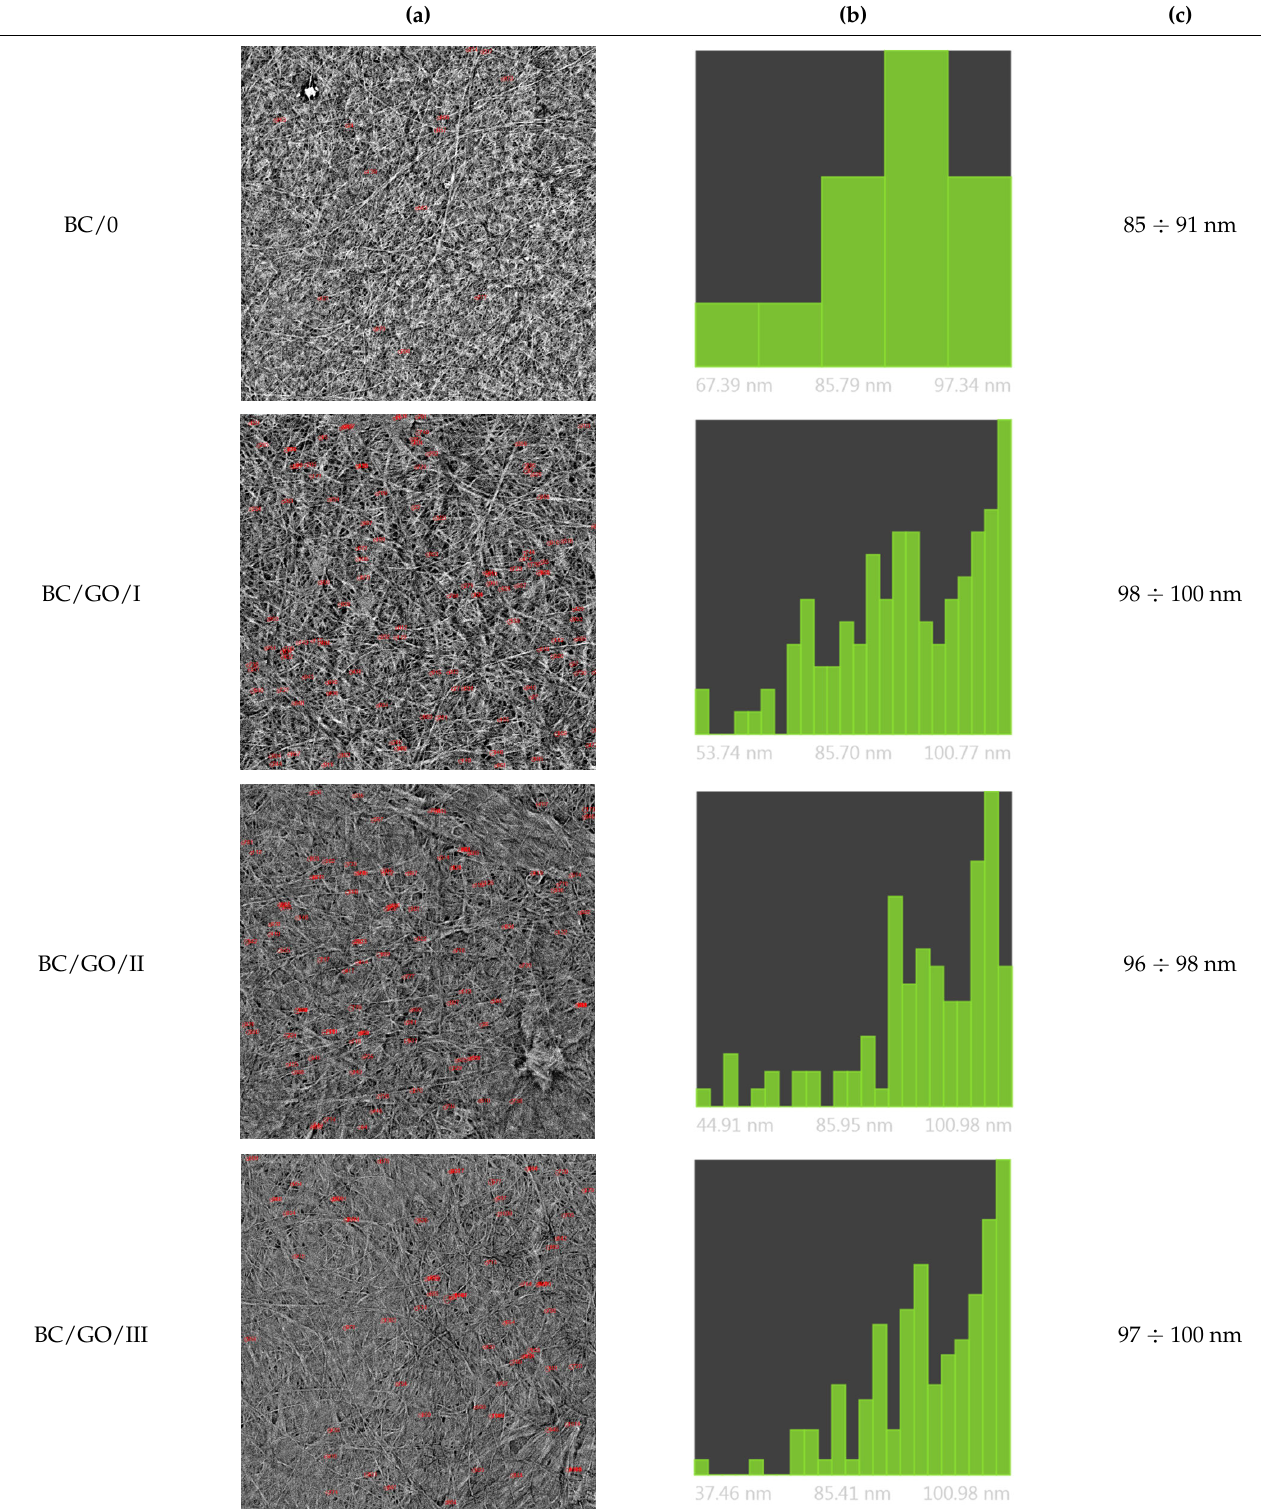
Table 3. Thickness dispersion of BC fibers in the following membranes: BC/0, BC/GO/I, BC/GO/II and BC/GO/III, measured using FiberMetric software: (a) photo of the sample with measurements (at 10,000 × magnification); (b) a histogram of BC fibers diameter distribution; (c) mean fiber diameter (nm) measured in the test range from 0 to 100 nm.